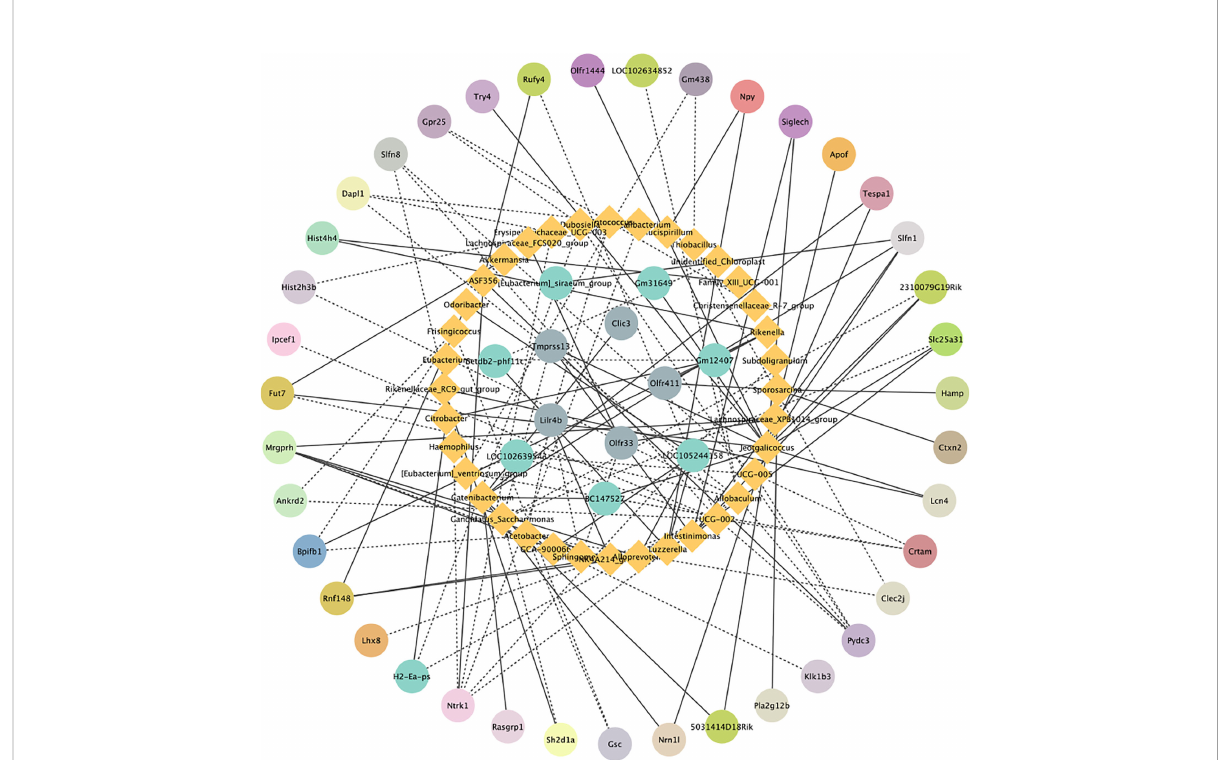
FIGURE 7 Correlation analysis graph of differentially expressed genes and microorganisms. Blue represents microorganisms and other colors represent enriched DEGs in the same pathway. The solid lines indicate a positive correlation and the dashed line indicates a negative